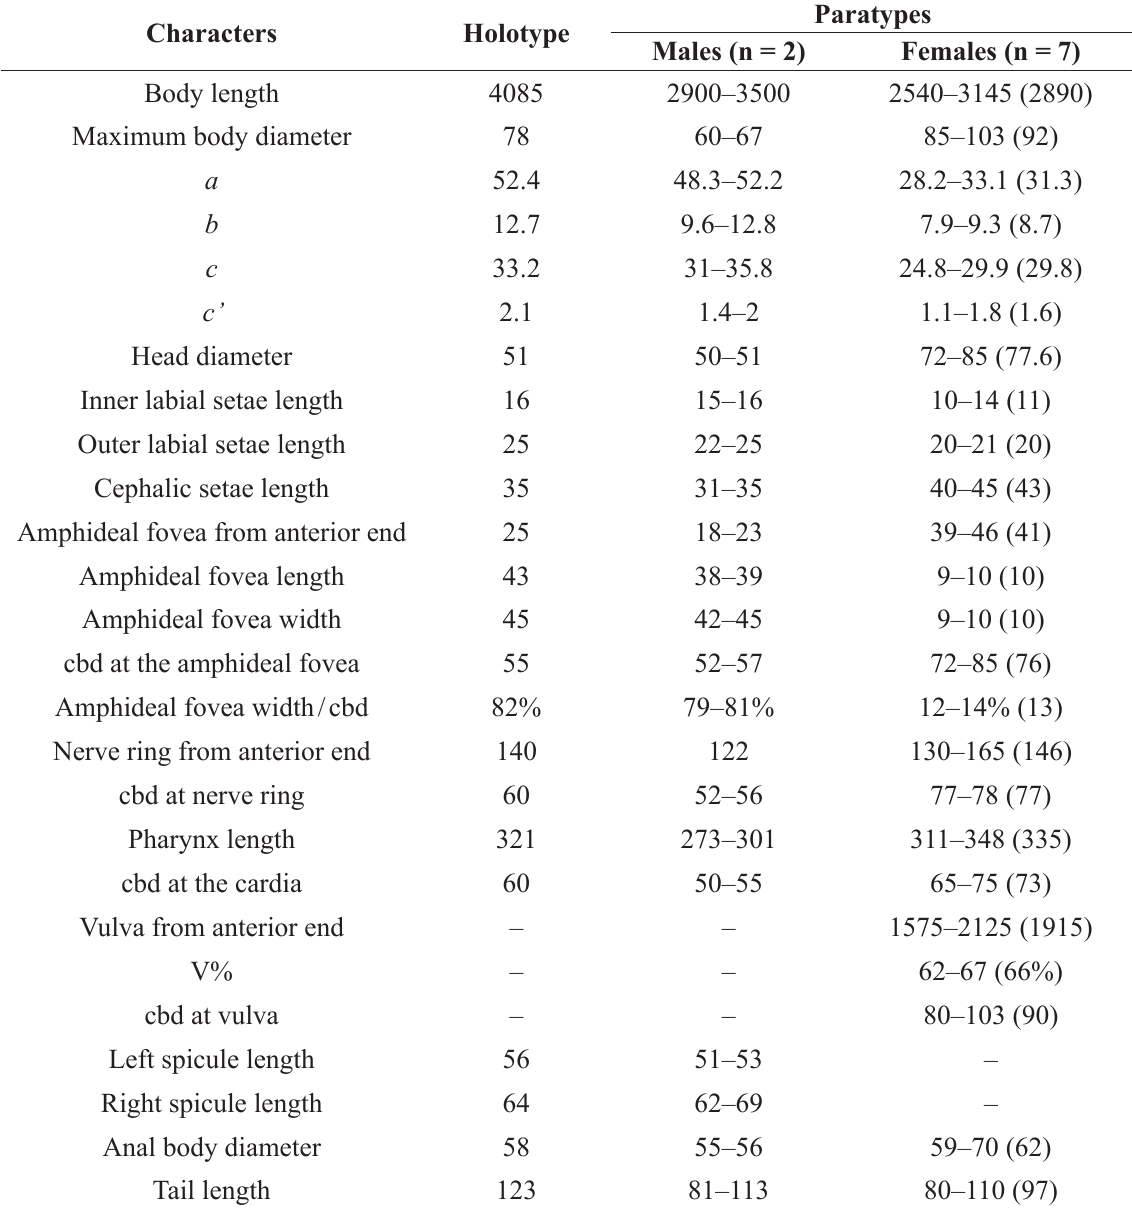
Table 1. Morphometrics (measurements in μm) of Gammanema magnum sp. nov. Mean values for female paratypes are shown in